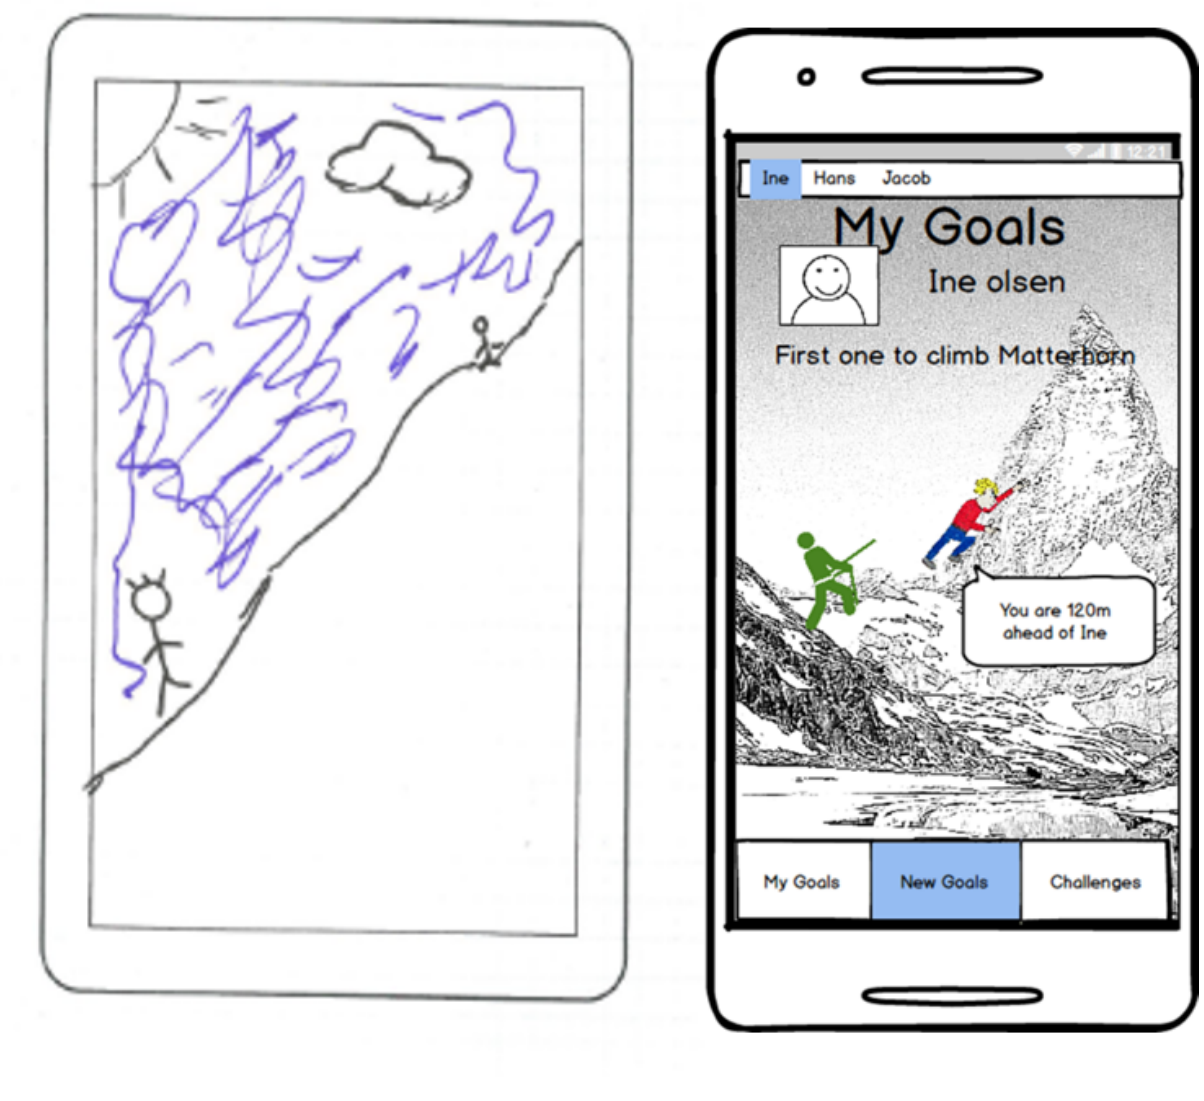
Figure 7. Participant drawing from workshop 1, and refined prototype wireframe for workshop